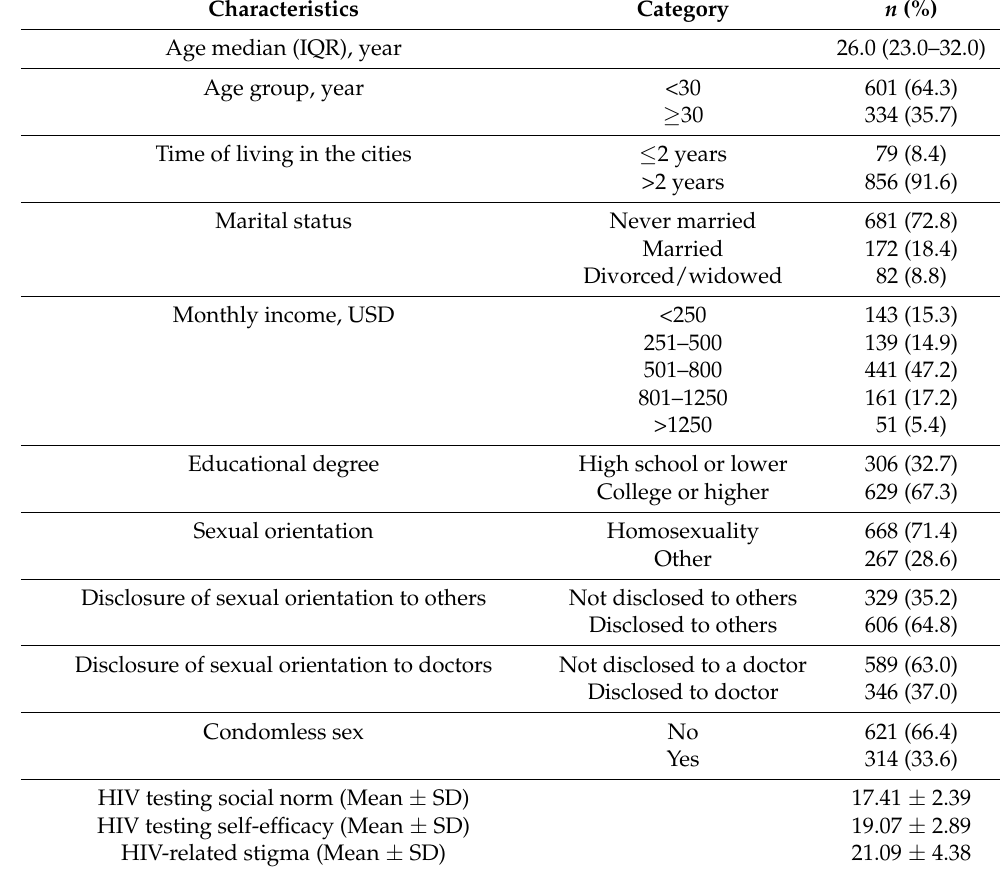
Table 1. Characteristics of